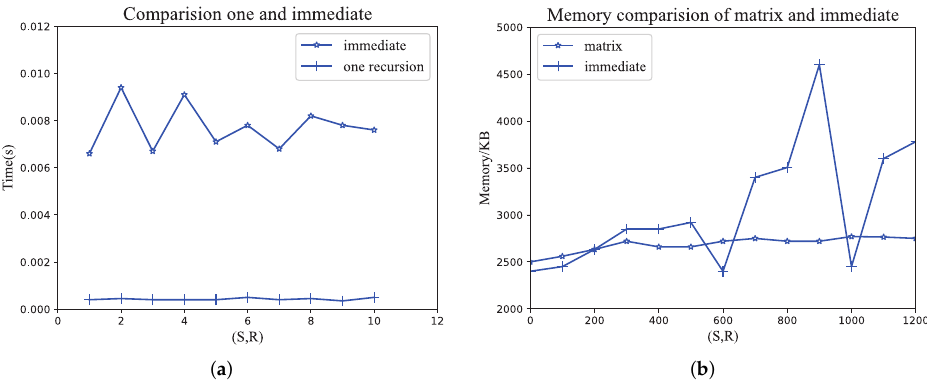
Figure 7. Comparison of real-time computing and the threat matrix in terms of time complexity and memory usage: ( a ) comparison of time complexity; ( b ) comparison of memory